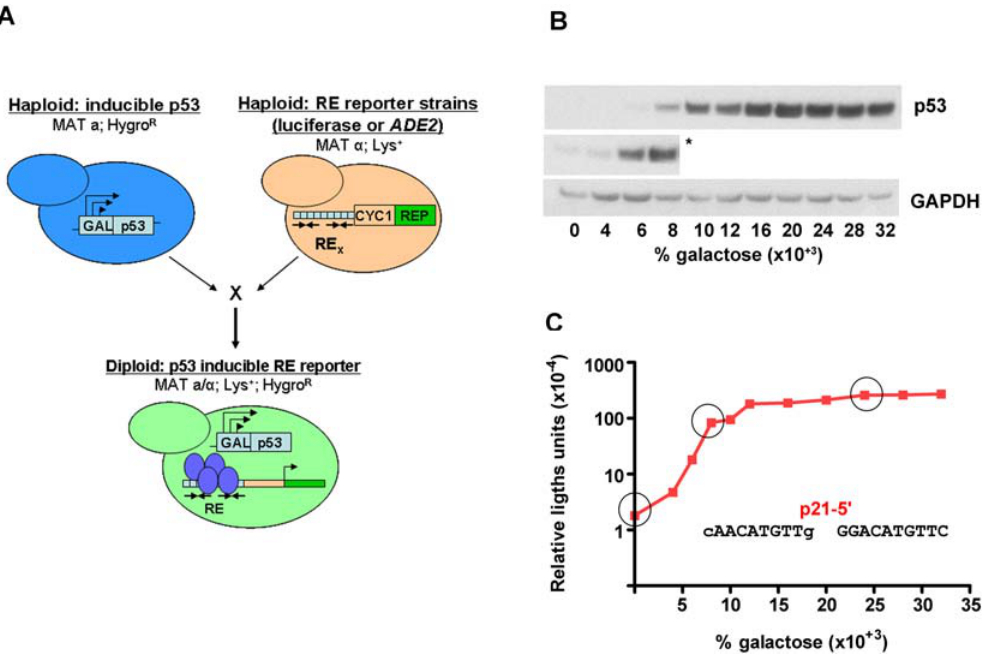
Figure 1. Isogenomic diploid yeast system to investigate transcriptional capacity of p53 towards many REs at various p53 levels. (A) Transactivation capacities of p53 (WT or mutant) from cognate REs were determined using diploid strains derived from haploids where p53 and reporters with upstream REs were integrated into different chromosomal loci. Within the p53-host strains, p53 (WT or mutant) was controlled by a ‘‘rheostatable’’ GAL1 promoter (blue cells) (previously described [109]) which allows for controlled, inducible expression of p53. Reporter strains contained promoter REs upstream of the minimal CYC1 promoter and either the ADE2 color reporter (REP) or the firefly luciferase reporter (tan cells) [28]. Mating of the REP and p53-host strains results in isogenomic diploid yeast that provide for rapid assessment of the transactivation potential for WT or mutant p53 proteins towards many individual REs in the p53 transcriptional network [14]. (B) Inducible expression of p53 under the rheostatable GAL1 promoter. The GAL1 promoter allows for controlled expression of p53 depending on the level of galactose in the media. Raffinose was added to provide a basal level of expression, as the GAL1 promoter is derepressed, but not induced in media containing this carbon source. Presented is a Western blot analysis of p53 expression 24 hours post-inoculation with raffinose or raffinose plus increasing amounts of galactose (0.004–0.032%). Increases in galactose from 0–0.032% correlated with an increase in p53 over a 100-fold range. The p53 protein was detected with DO-1 and pAb1801 antibodies. The asterisk (*) depicts a longer exposure to reveal protein at basal and lower galactose levels. GAPDH, identified by immunodetection provided a standard loading control. (C) Quantitative assessment of p53-induced transactivation from the p21-5 9 RE in vivo . The diploid yeast strain containing GAL1 ::WT p53 crossed with the p21-5 9 RE-luciferase REP was grown overnight in complete medium, diluted, washed and inoculated into selective medium containing either raffinose or raffinose plus increasing galactose (0–0.032%) for 24 hours. Protein lysates were obtained and a luciferase assay was used to determine the transactivation capacity of p53 from the p21-5 9 RE. The strength of transactivation was calculated as relative light units/ m g protein. Circled are the basal, linear-increase, and plateau phases of the transactivation response as a function of galactose concentration and are referred to as basal, moderate and high levels of p53